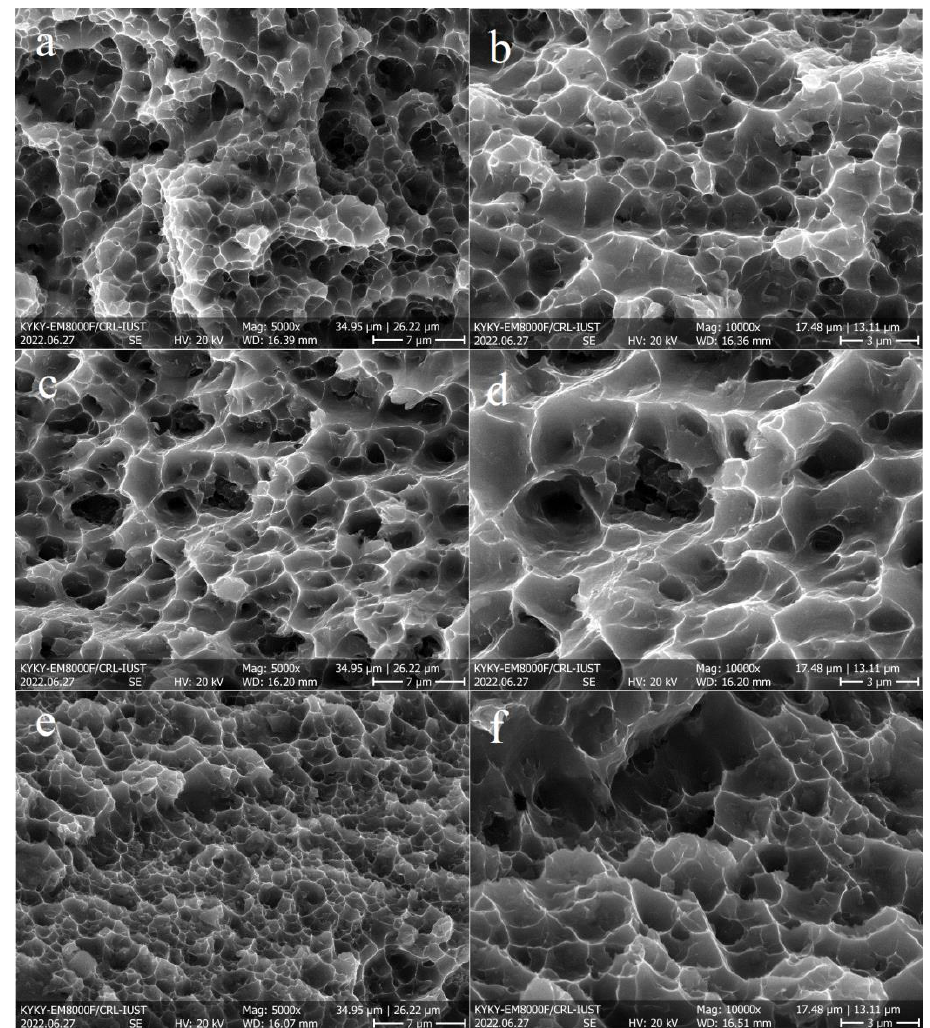
Figure 12. Secondary electron SEM images of fractured surfaces at different magnifications: ( a , b ) S1, ( c , d ) S2, and ( e , f ) S3.